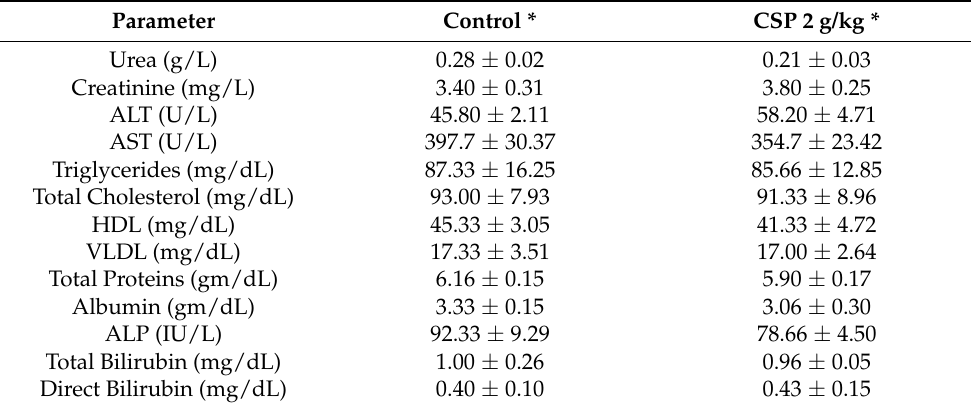
Table 3. Biochemical parameters of